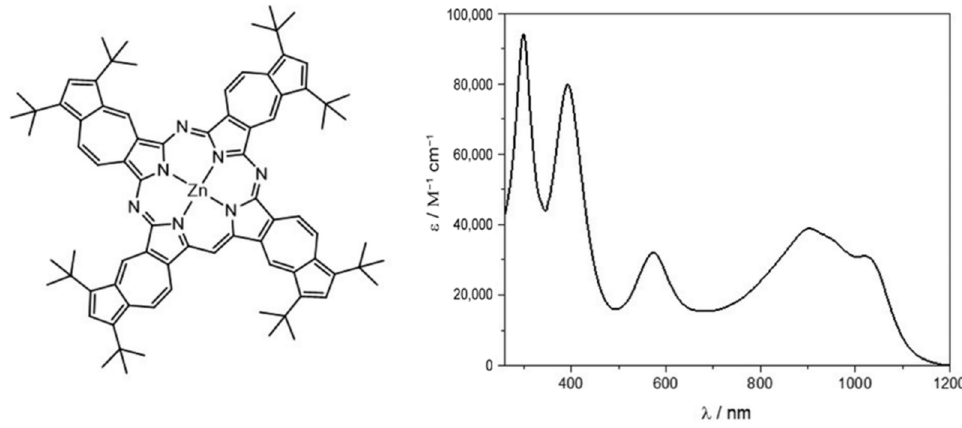
Figure 5. Azulenocyanine π -extended system and absorption spectrum. Reproduced from [60] with the permission of the Royal Society of